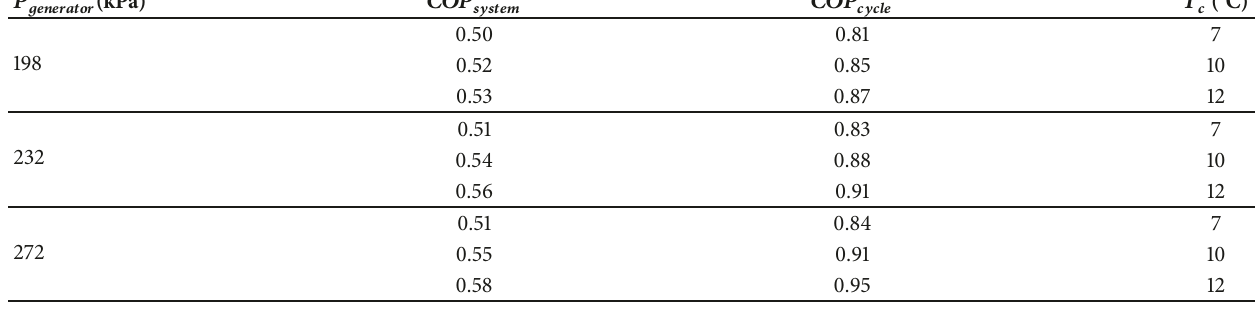
Table 7: Maximum 𝐶𝑂𝑃 reached for solution generator temperature set at 210 ∘ C (maximum considered) and 𝑇 𝑐𝑤 = 32 ∘ C. 𝑃 𝑔𝑒𝑛𝑒𝑟𝑎𝑡𝑜𝑟 (kPa)